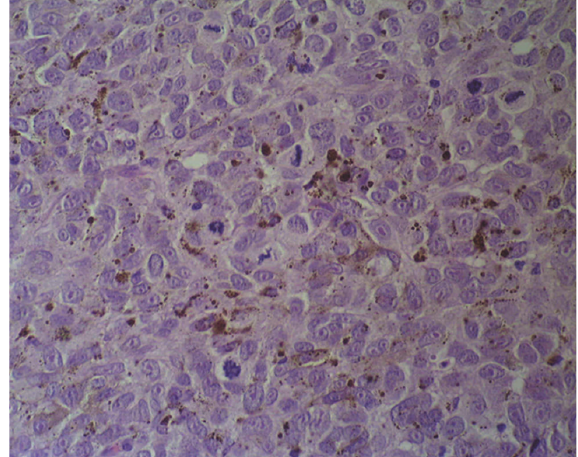
Figure 2: Nests of atypical melanocytes, with the large nuclei showing prominent nucleoli and numerous mitotic figures (haema- toxylin and eosin stain × 400).